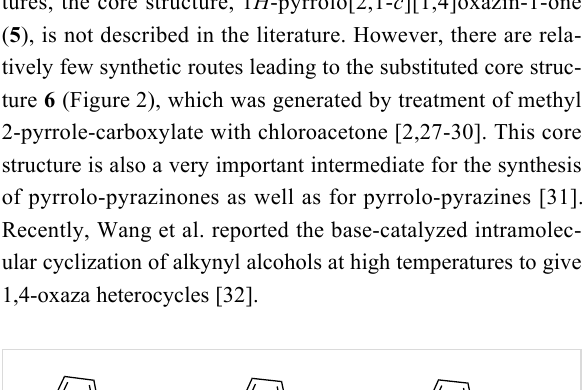
tures, the core structure, 1 H -pyrrolo[2,1- c ][1,4]oxazin-1-one